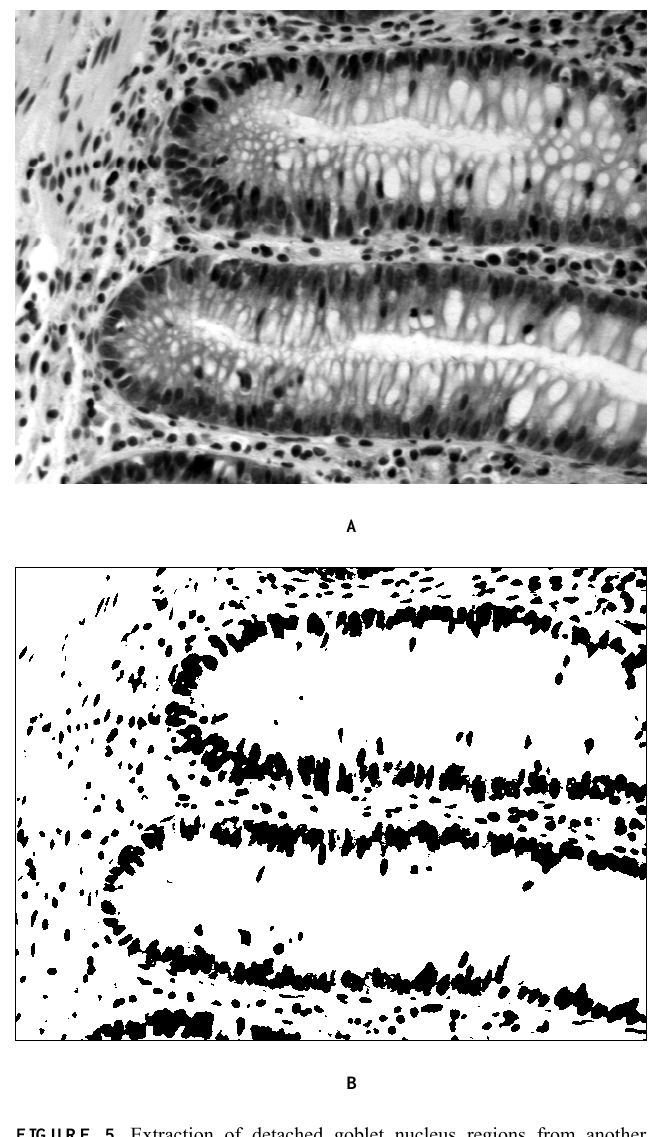
FIGURE 5 . Extraction of detached goblet nucleus regions from another nuclear image. (A) Another original intestine gland image; (B) threshold- segmented; (C) erosion of image in (B) by a round structure element of radius of three pixels; (D) conditional dilation of image in (A) by a round structure element of radius of three; (E) retaining the isolated single cells after the attached cells being removed from